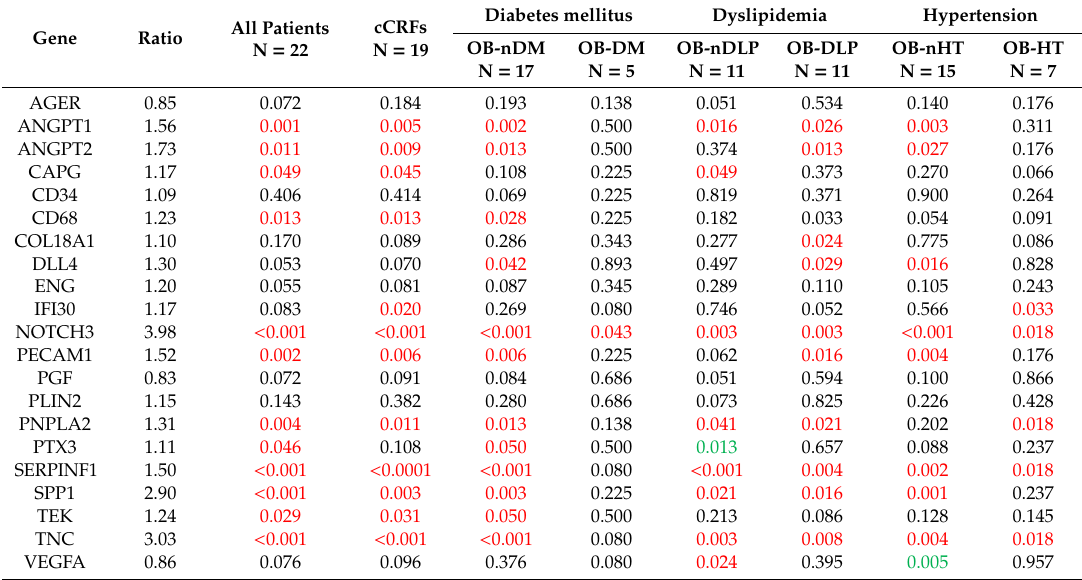
Table 3. Di ff erential genomic expression in SAT versus the visceral adipose tissue (VAT) of patients with obesity with di ff erent number of